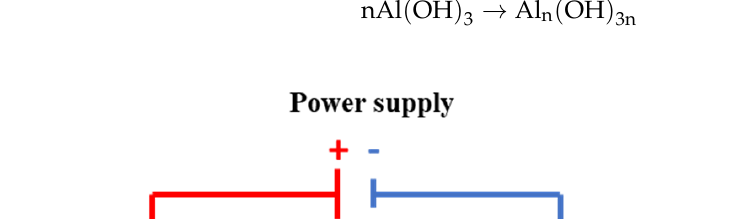
In addition, Al 3 + and Al ( OH ) 2 + are produced by the electrolytic dissolution of the aluminum anode at low pH values. Both of the cationic monomeric species transform initially into Al ( OH ) , then polymerize to Al n ( OH ) at appropriate pH values [4]: 3 3n